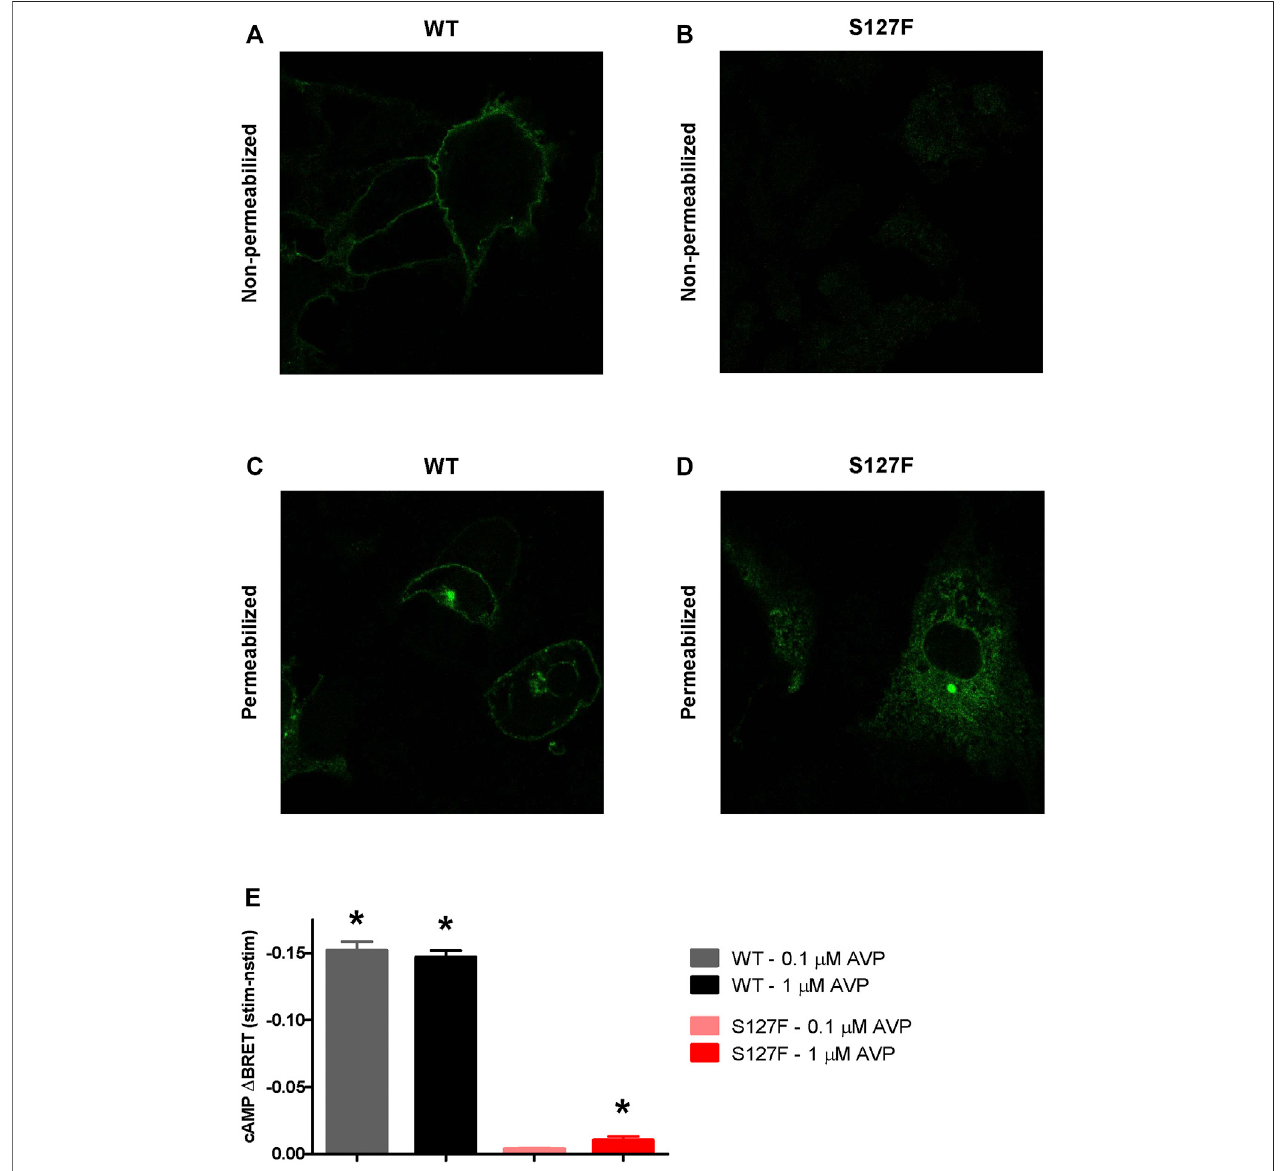
FIGURE 2 | Characterization of the cellular localization and cAMP signaling of the wild-type and S127F mutant V2 receptors. (A – D) Examination of the cell surface and intracellular expressionofthewild-typeandS127FV2Rs usingconfocalmicroscopy.HEK293cellsweretransientlytransfectedwiththeplasmids ofWT-V2R-HA or S127F-V2R-HA. The HA-tag-containing receptor variants were directly immunostained with anti-HA-Alexa488 mouse monoclonal antibody. (A) WT-V2R and (B) S127F-V2R presence at the cell surface was analyzed after immunostaining of non-permeabilized fi xed cells, whereas the total cellular distribution of (C) WT-V2R and (D) S127F-V2R was assessed after staining permeabilized cells. (E) Measurement of cAMP production after AVP stimulation. HEK293 cells were transiently transfected with the plasmids of the Epac-BRET sensor and either WT-V2R or S127F-V2R. The cells were treated either with vehicle (nstim) or with the indicated concentration of AVP (stim) and the BRET ratios were monitored. The effect of stimulation was calculated as the BRET ratio difference between the AVP (stim) and the vehicle (nstim) exposed cells after 500 s of treatment. Mean values ±S.E. are shown ( n = 3). Signi fi cance was calculated with one-way ANOVA test (* p < 0.05).